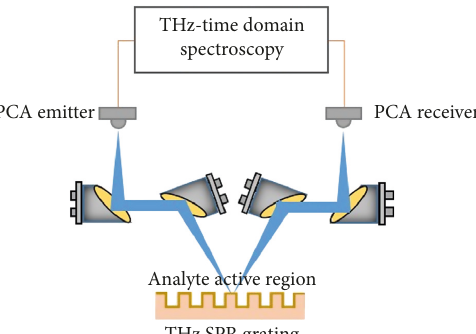
Figure 2: A THz refractive index sensing experiment setup integrating a SPR grating with THz TDS in a reflection measurement mode. The measurement should be carried out in a low-humidity environment and at room temperature to avoid strong THz attenuation due to